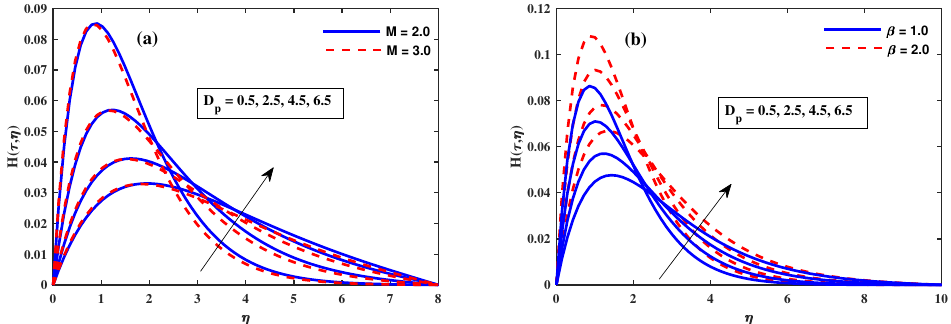
Figure 3. Curve of H ( τ , η ) against D p (nanoparticle radius), M ( a ), and β ( b ).